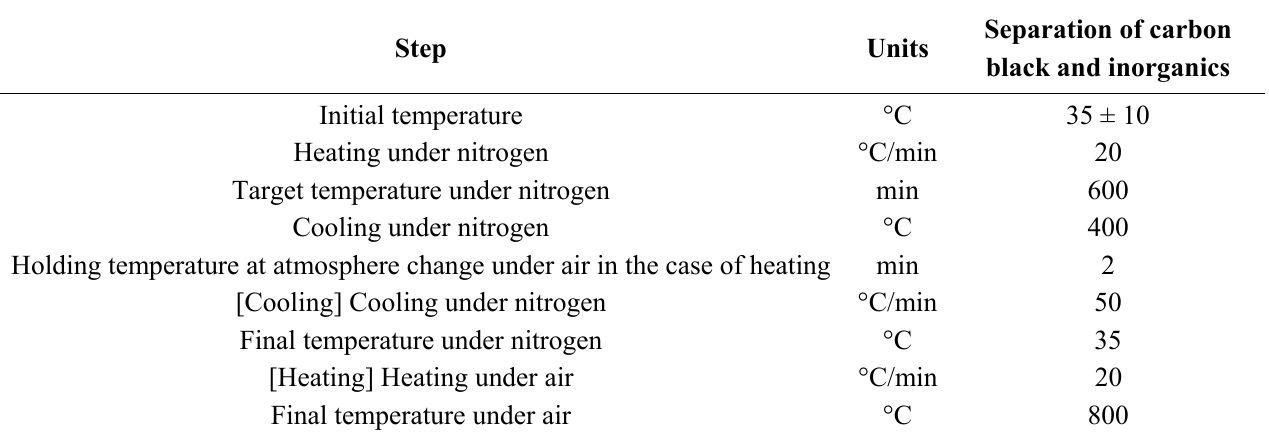
Table 6. Operating conditions for separation of CB and/or inorganics by thermogravimetry.